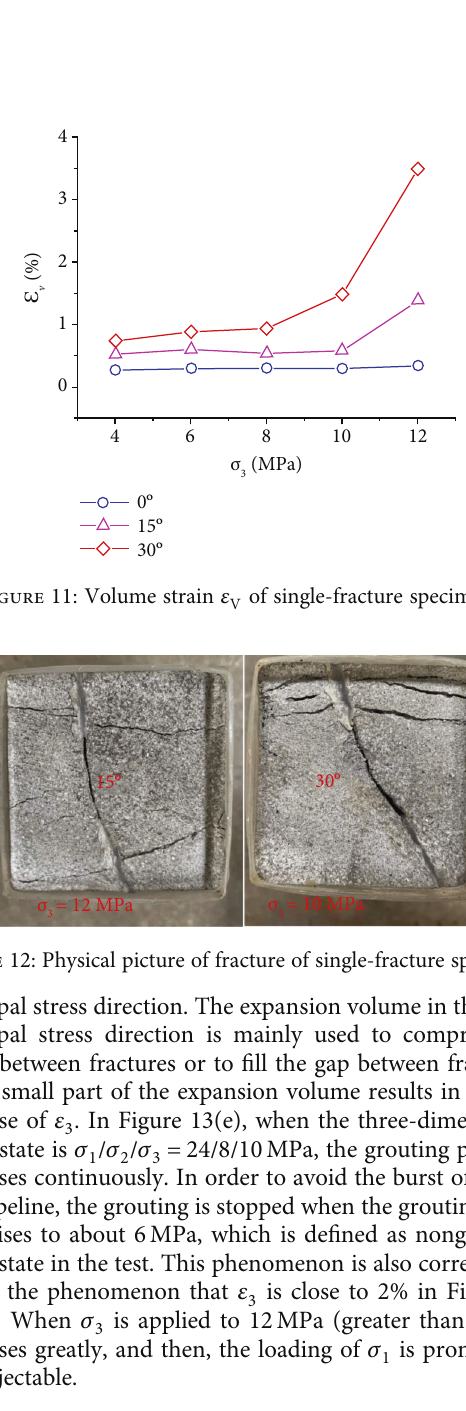
1 ) relationship under di